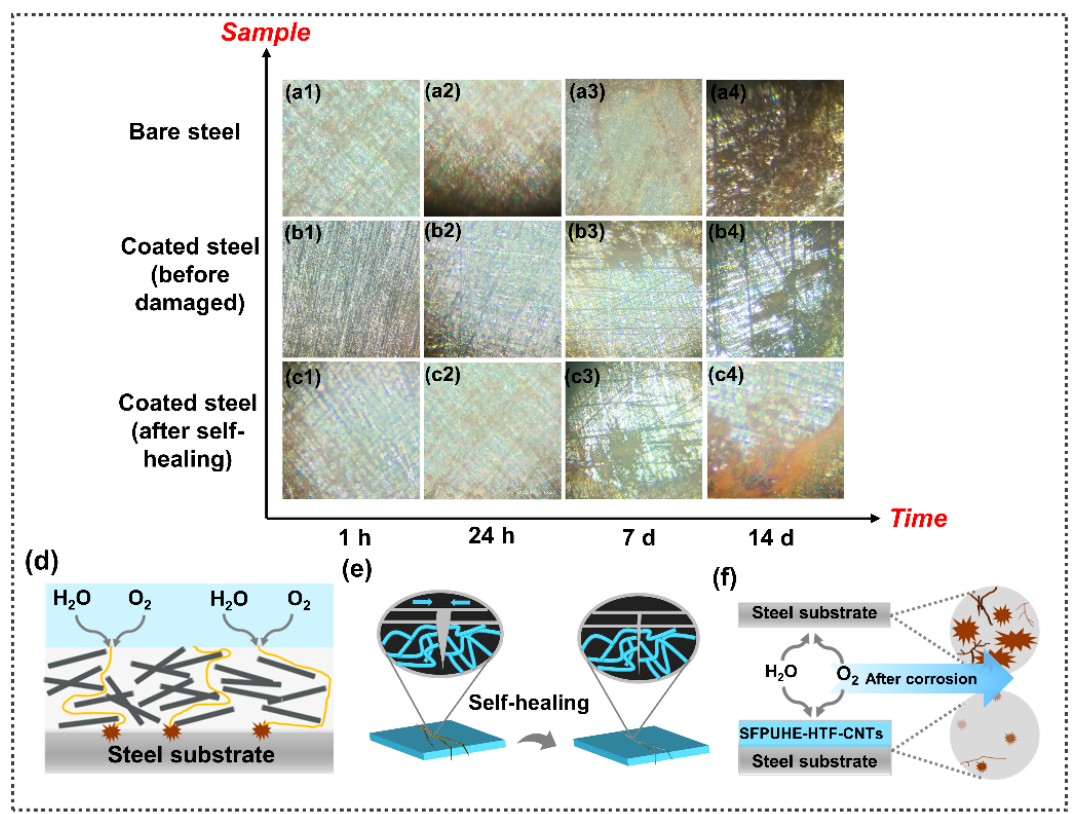
Figure 8. Micrographs (1000×) of surface corrosion of different samples in a 3.5 wt% NaCl solution for 1 h, 24 h, 7 d and 14 d: ( a1 – a4 ) bare steel sheets; and SFPUHE-HTF-CNTs-3-coated steel sheets ( b1 – b4 ) before and ( c1 – c4 ) after self-repair. ( d ) Schematic diagram of the zigzag barrier channels formed by CNTs in the outer layer of SFPUHE-HTF-CNTs. ( e ) Schematic diagram of the self-healing effect of the polyurethane inner layer of SFPUHE-HTF-CNTs. ( f ) Schematic diagram of the anti-